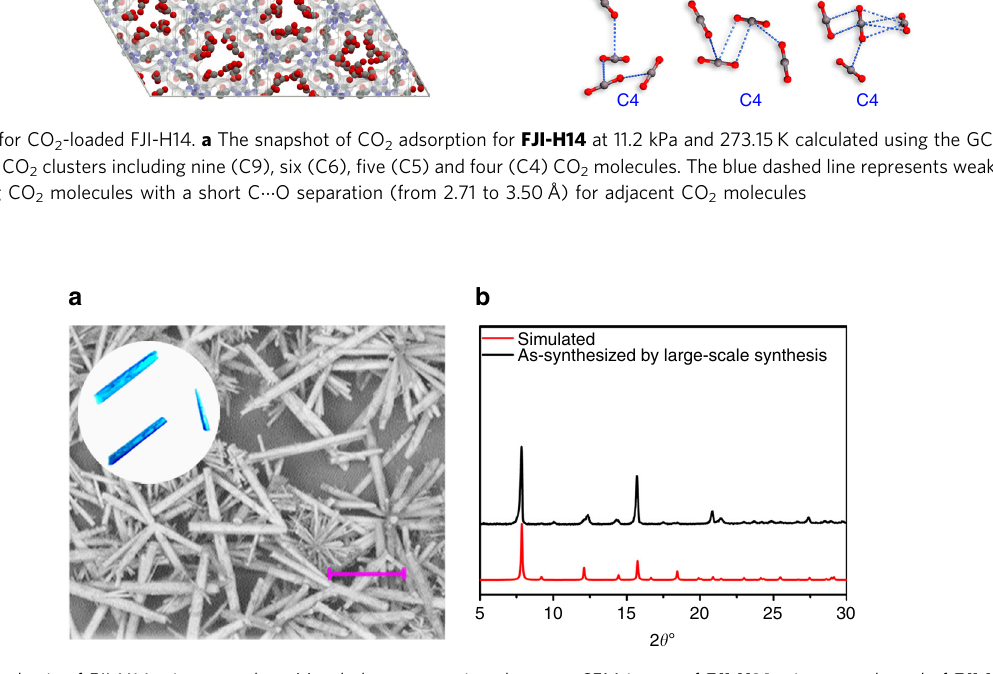
Fig. 6 Large-scale synthesis of FJI-H14 microcrystals. a Morphology comparison between SEM image of FJI-H14 microcrystals and of FJI-H14 single crystals (inset). Scale bars, 10 µ m. b PXRD patterns comparison: black represents simulated FJI-H14 ; red represents FJI-H14